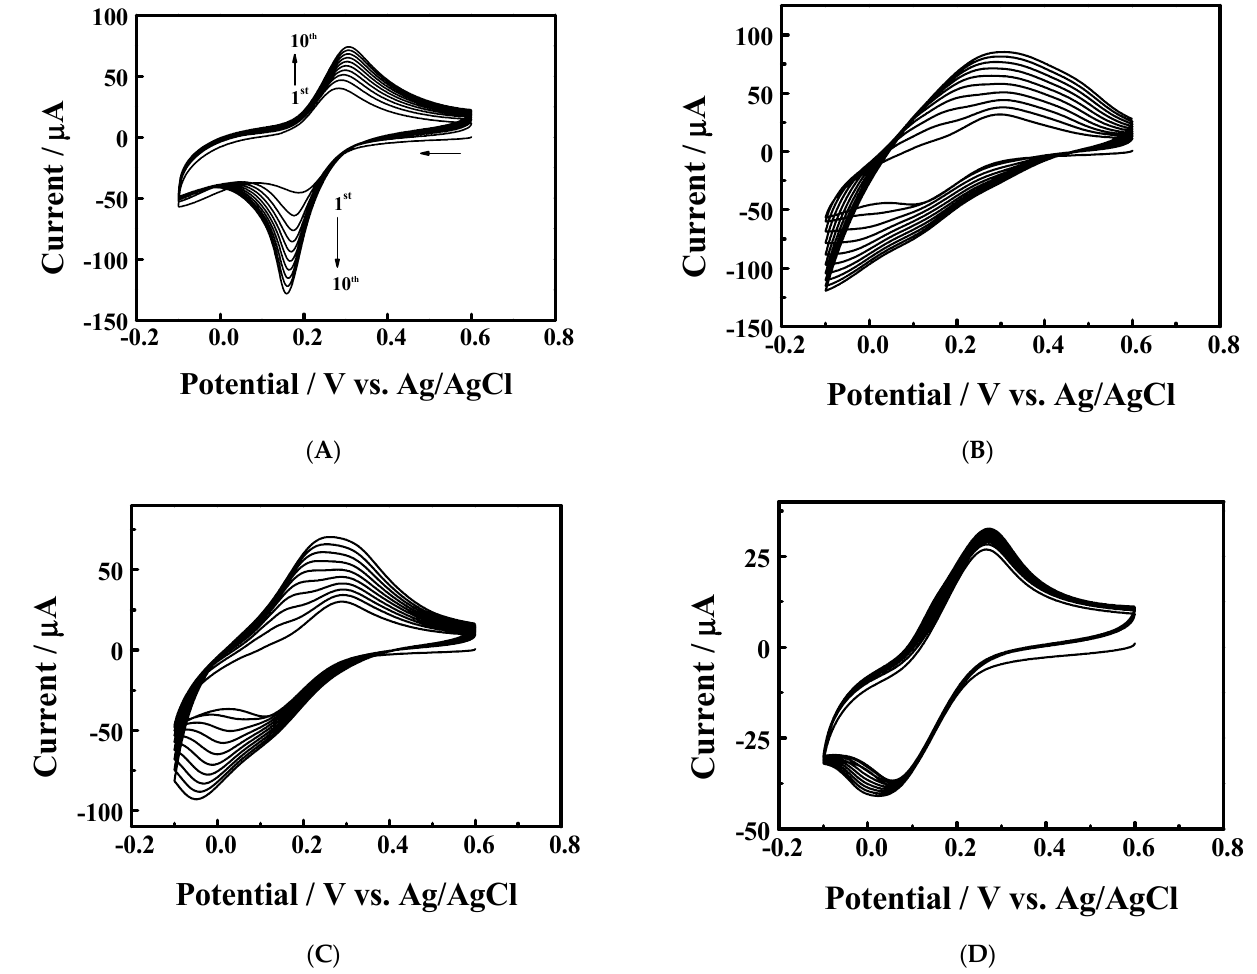
Figure 1. Cyclic voltammograms of SPCE/nano − Fe 3 O 4 in ( A ) Solution I, ( B ) Solution II, ( C ) Solution III, and ( D ) Solution IV for 10 cycles. Scan rate = 0.1 Vs − 1 . Table 1. The electrolytic solutions used for the electrochemical deposition of Prussian blue nano- particles at SPCE/nano-Fe 3 O 4